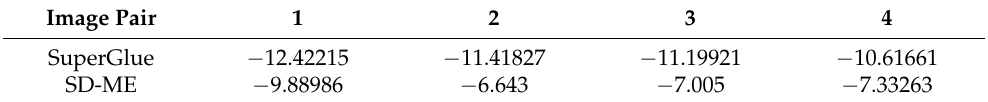
Table 2. Distributional uniformity of SuperGlue and SD-ME matching points. Image Pair 1